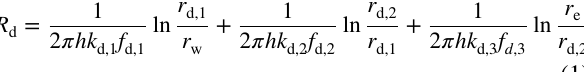
Fig. 1 The phase diagram of the study